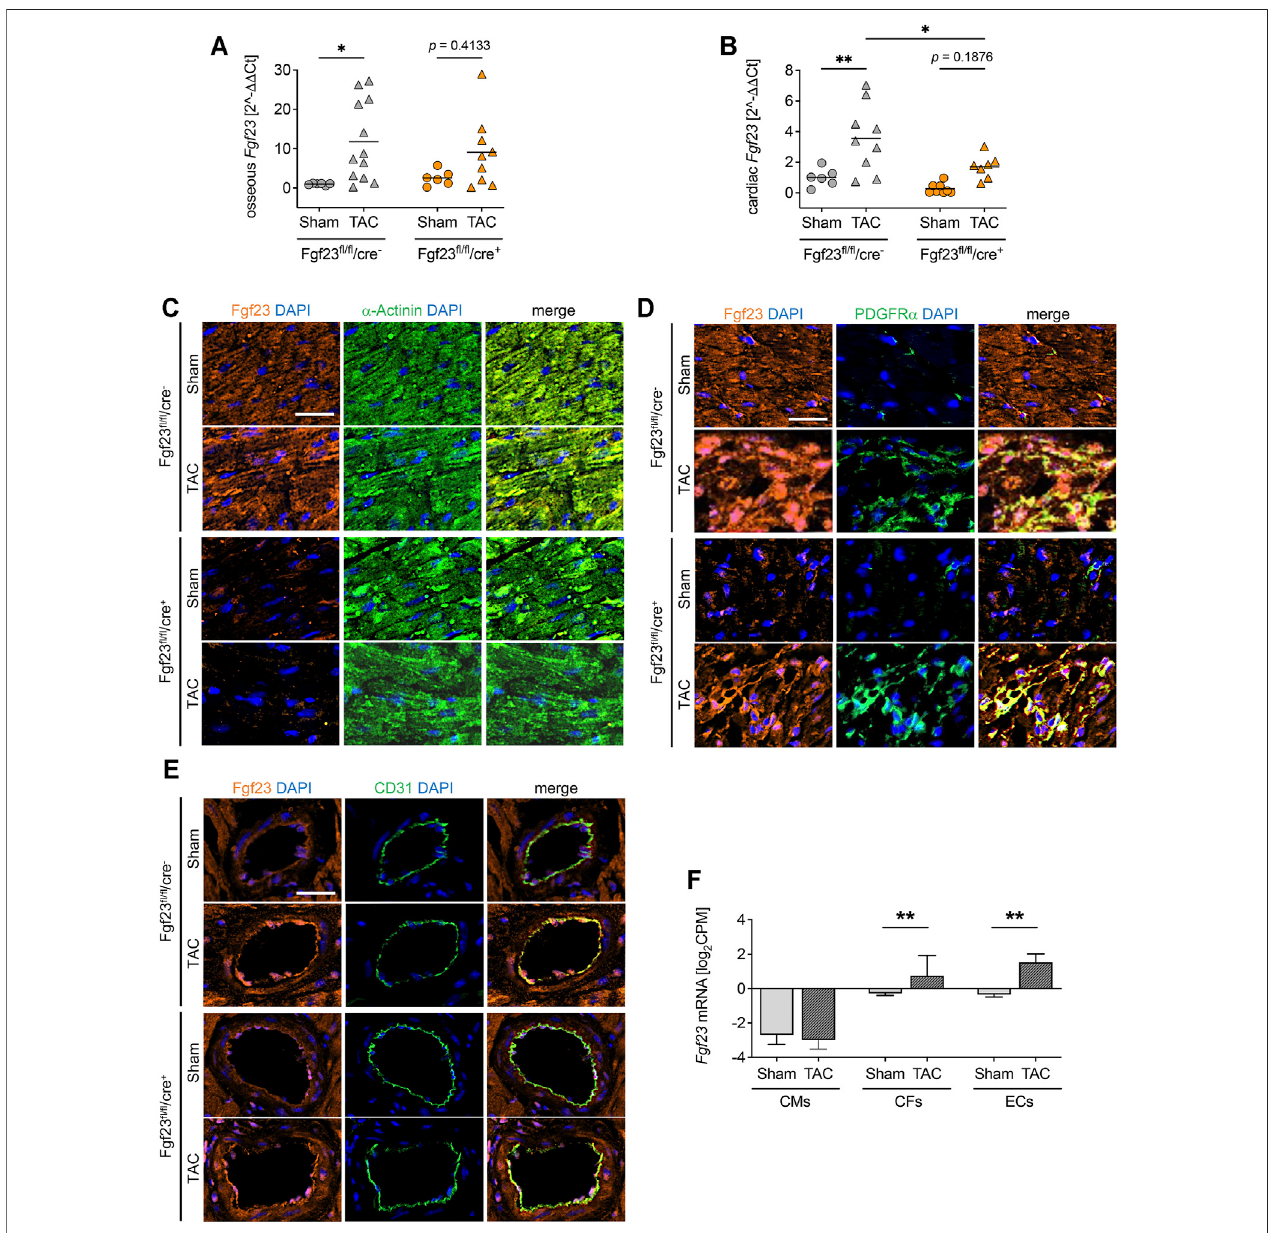
FIGURE 7 | High blood pressure induces Fgf23 synthesis in cardiac fi broblasts and endothelial cells. (A, B) Osseous and cardiac Fgf23 mRNA expression is increased in TAC-operated Fgf23 fl / fl /cre − and Fgf23 fl / fl /cre + mice, although cardiac Fgf23 levels are lower in Fgf23 fl / fl /cre + mice compared to Fgf23 fl / fl /cre − controls. Data isgiven asscatter dotplotswith means;* p < 0.05and ** p < 0.01analyzedbyTwo-way ANOVA followedbyTukey ’ smultiplecomparison test; n (cid:2) 6 – 12miceper group. (C – D) Co-immuno fl uorescence images of sham and TAC-operated Fgf23 fl / fl /cre − and Fgf23 fl / fl /cre + mice stained for Fgf23 (orange) with DAPI for nuclei (blue) and (C) α -Actinin, (D) PDGFR α or (E) CD31(eachin green). Magni fi cation × 20, scalebar 25 µm. (F) Cardiac celltype speci fi cisolation followed byRNA-sequencing analysis from isolated cardiac myocytes (CMs), cardiac fi broblasts (CFs) and endothelial cells (ECs) after TAC or sham surgery. CPM indicates counts per million reads. Data is given as mean ± SEM of n (cid:2) 3 cell isolations per group; ** p < 0.01 analyzed by two-tailed Student ’ s t -test.